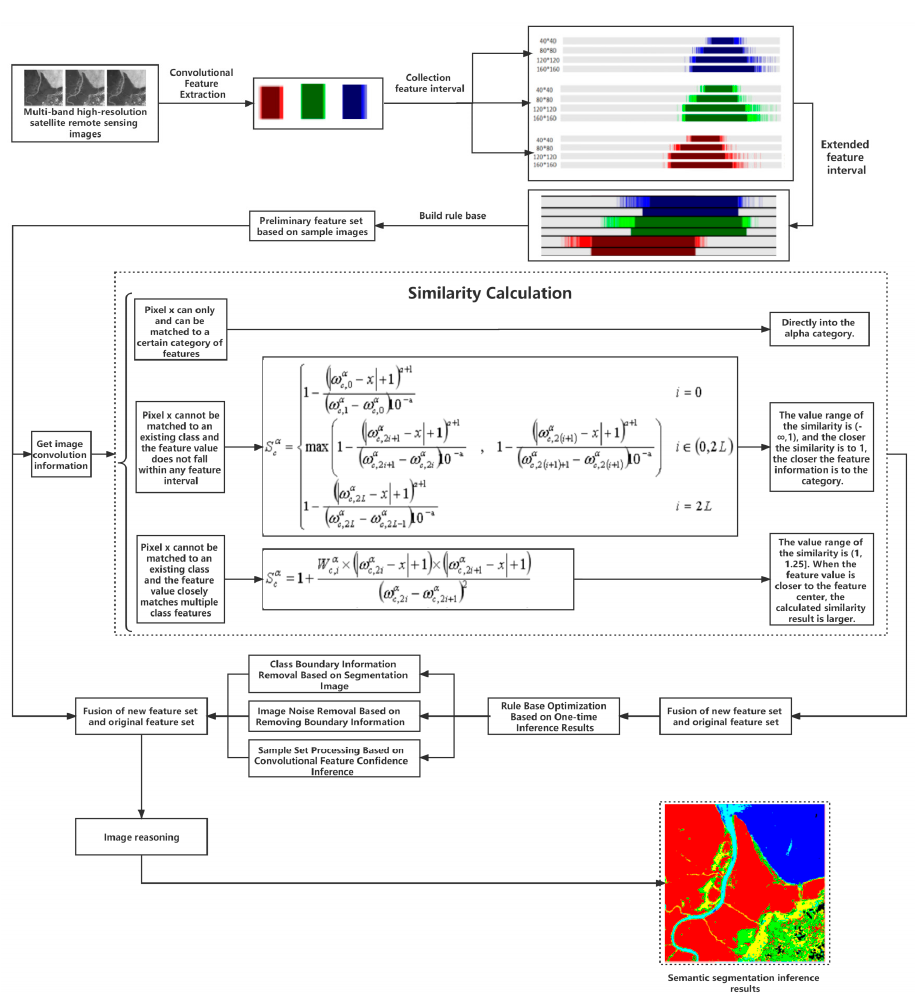
Figure 2. Flow of rule construction and semantic inference method.